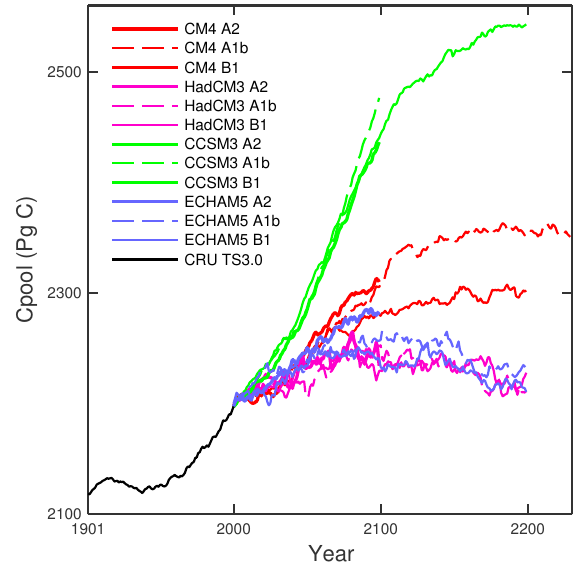
Fig. 1. Evolution of the global terrestrial ecosystem carbon pool (Cpool) under twelve future scenario simulations with LPJ-GUESS. 2